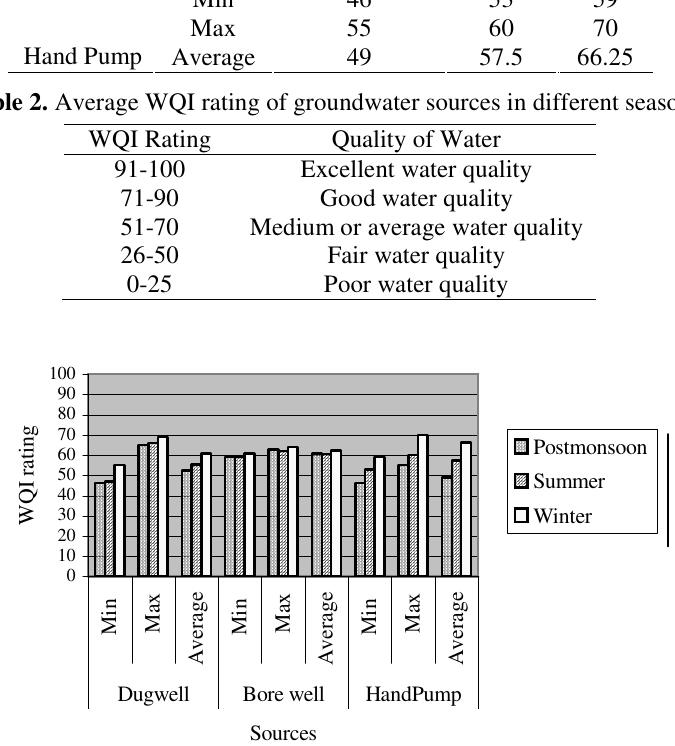
Figure 1. Representation of WQI rating in all